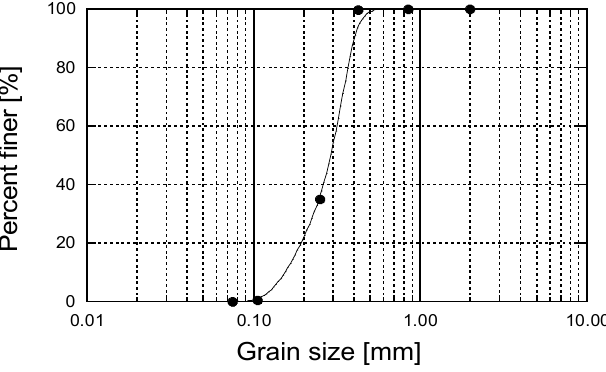
Figure 1. Particle size distribution of silica sand #6 used in this work [4,30].